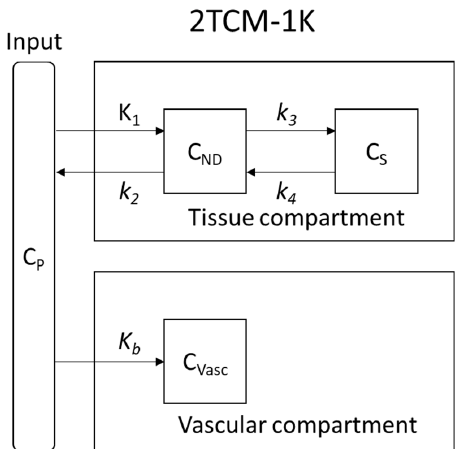
Figure 1. 2TCM-1K pharmacokinetic model: K 1 and k 2 are the rate constant between the plasmatic compartment (C P ) and the non-displaceable compartment (C ND , free and non-specific fixation); k 3 and k 4 are the rate constant for input and output, respectively, between C ND and specific fixation compartment (C S ). K b is the input rate constant between C P and the vascular non-reversible fixation compartment (C VASC